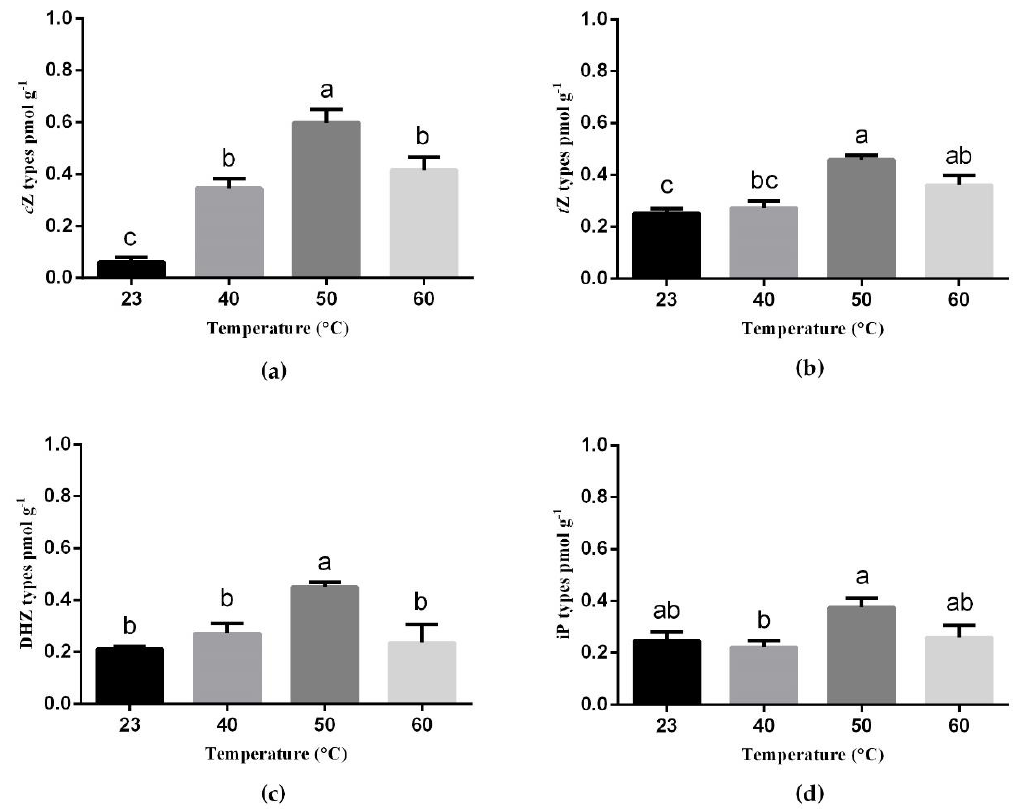
Figure 6. Effect of different temperatures (23 °C, 9 weeks; 40 °C, 4 h; 50 °C, 30 min; 60 °C, 5 min) on Figure 6. E ff ect of di ff erent temperatures (23 ◦ C, 9 weeks; 40 ◦ C, 4 h; 50 ◦ C, 30 min; 60 ◦ C, 5 min) on the the endogenous concentration (pmol g −1 FW± SE) of ( a ) total c Z types; ( b ) total t Z types; ( c ) total DHZ endogenous concentration (pmol g − 1 FW ± SE) of ( a ) total c Z types; ( b ) total t Z types; ( c ) total DHZ types; ( d ) total iP types types; ( d ) total iP types cytokinins.